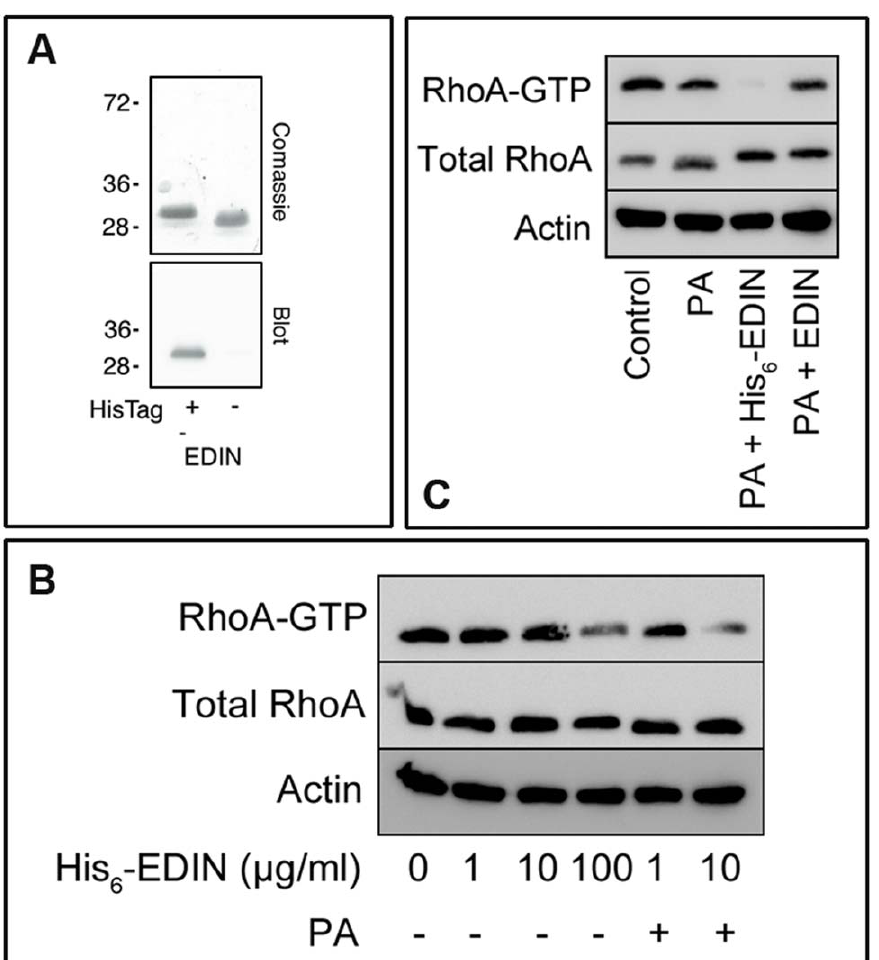
Figure 3. His 6 -tag allows internalization of EDIN in endothelial cells through PA 63 . A: Upper panel: SDS-PAGE of recombinant His 6 -tagged EDIN before (left) and after thrombin treatment (right). Lower panel: immunoblot anti–His 6 -tag on His 6 -tagged EDIN before and after cleavage by thrombin. B, C: Immunoblots showing cellular levels of active RhoA (RhoA-GTP) in HUVECs determined by GST-Rhotekin RBD pulldown (labeled RhoA-GTP). Cellular content of RhoA (Total RhoA) was assessed by anti-RhoA on 2% of total protein extracts. Immunoblot anti-actin antibody exhibits equal protein loading. (B) Cells were intoxicated with different concentrations of His 6 -EDIN (1, 10 and 100 m g/ml) with and without 3 m g/ml of PA 63 , as indicated. (C) Cells were intoxicated with 10 m g/ml His 6 -EDIN, 10 m g/ml EDIN, and 3 m g/ml PA 63 as